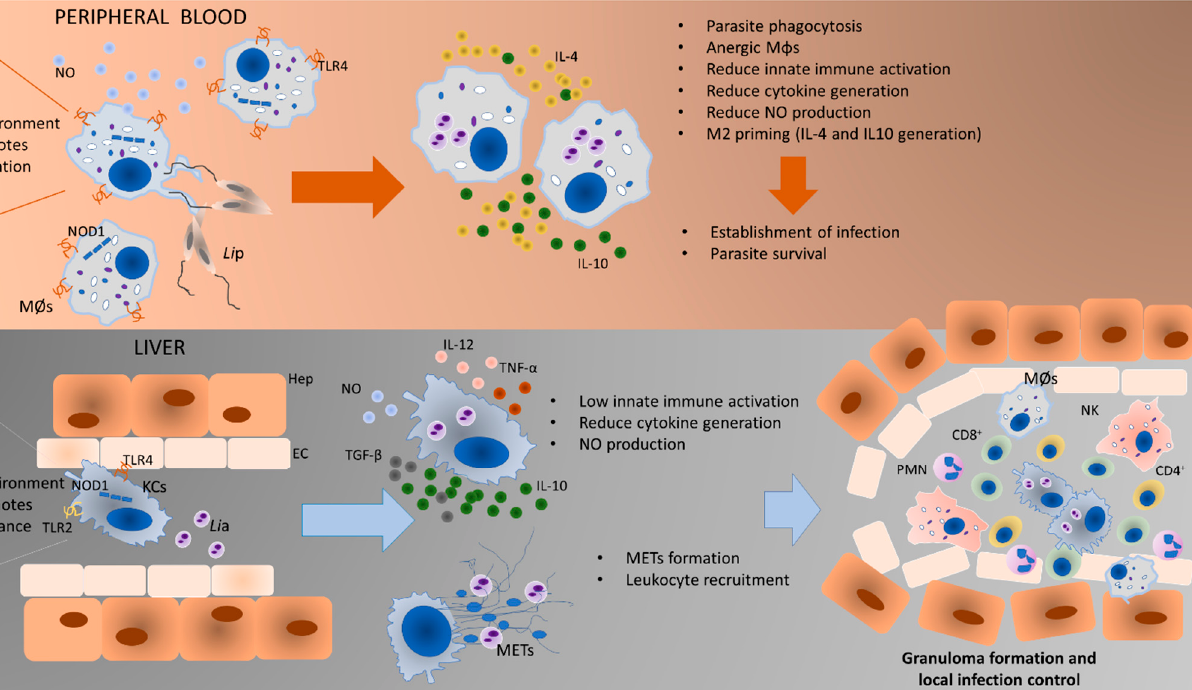
Figure 8. Proposed model of Leishmania- MØs interaction in blood and liver. Blood-MØs are rapidly activated in the presence of L. infantum , upregulating innate sensors (PRRs) and immune mediators (cytokines). However, shortly after parasite internalization blood-MØs became anergic and permissive to parasite survival. In the liver, KCs are primed by the microenvironment towards immune tolerance and exhibit low immune activation towards L. infantum . However, these cells can generate low levels of pro-inflammatory cytokines, release NO and emit METs in the presence of amastigotes, which will recruit other leukocytes and may initiate the constitution of a granuloma. The formation of granuloma is a typical hepatic structure associated with parasite restriction and local control of the infection. MØs-blood macrophages; Li p– L. infantum promastigotes; KCs-Kupffer cells; Li a– L. infantum amastigotes; METs-macrophage extracellular traps; TLR4-Toll-like receptor 4; TLR2-Toll-like receptor 2; NO-nitric oxide; NOD1-nucleotide-binding oligomerization domain-like (NOD) receptor 1; Hep-Hepatocyte; EC-Endothelial Cell; CD8 + -cytotoxic T lymphocytes; CD4 + -helper T lymphocytes; NK-Natural Killer cells; PMNs-Polymorphonuclear leukocytes.